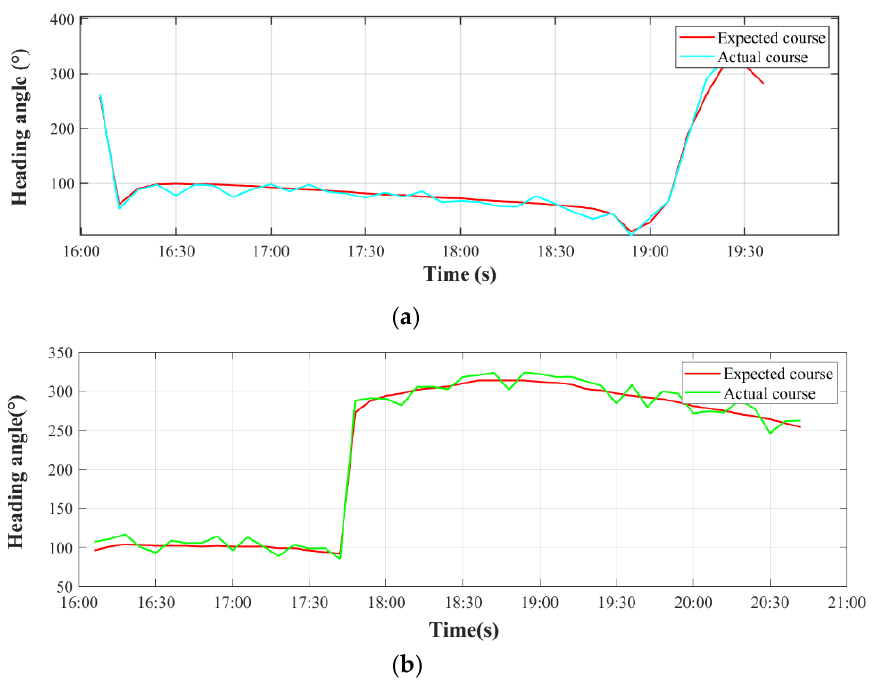
Figure 32. Comparison of actual course and expected course of the “ Black Pearl ” wave gliders. ( a ) The heading angle of the SALL submerged glider; and ( b ) the heading angle of the conventional submerged glider.